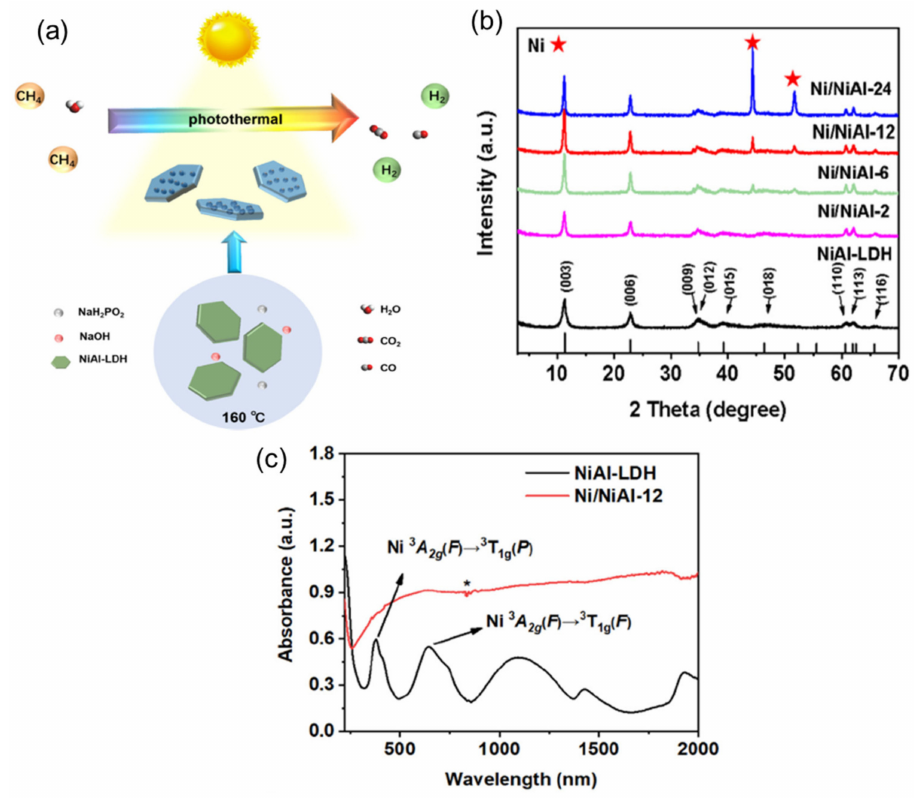
Figure 9. ( a ) Schematic illustration of the synthesis of Ni/NiAl-x for H 2 generation from CH 4 and H 2 O under solar light irradiation ( b ) XRD spectra of the samples produced under various reduction times and ( c ) UV–vis-IR absorption profiles of the obtained materials (The jump point marked by * is assigned to the instrument light) (Reprinted from [119] with permission of Elsevier,